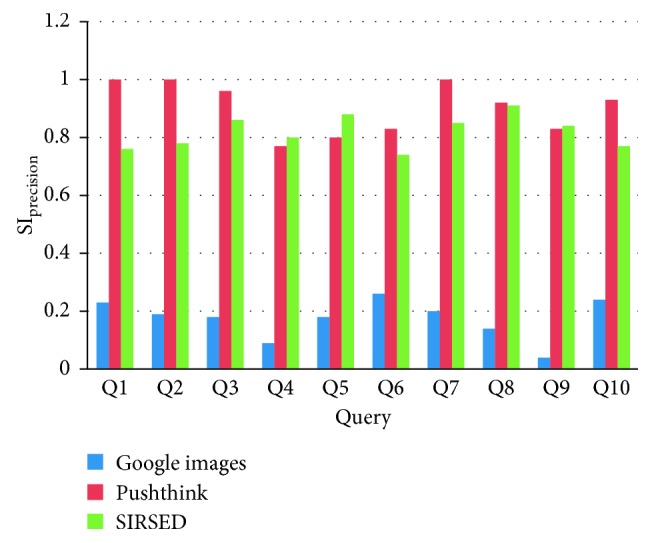
SIprecision@120 comparison.